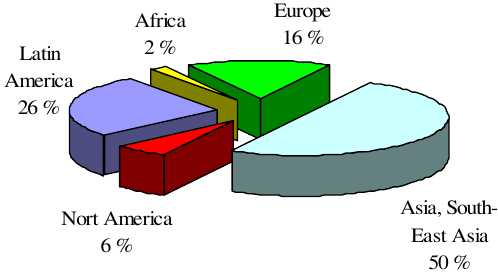
Fig 1. Distribution of Byelorussian potash export volumes among consumption regions